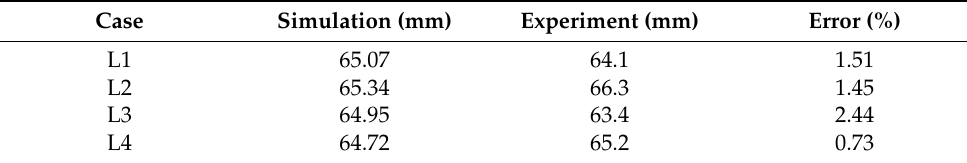
Figure 21. Comparison in-plane deformations between formed products and simulation. Table 6. CFRTP composite in-plane deformation error